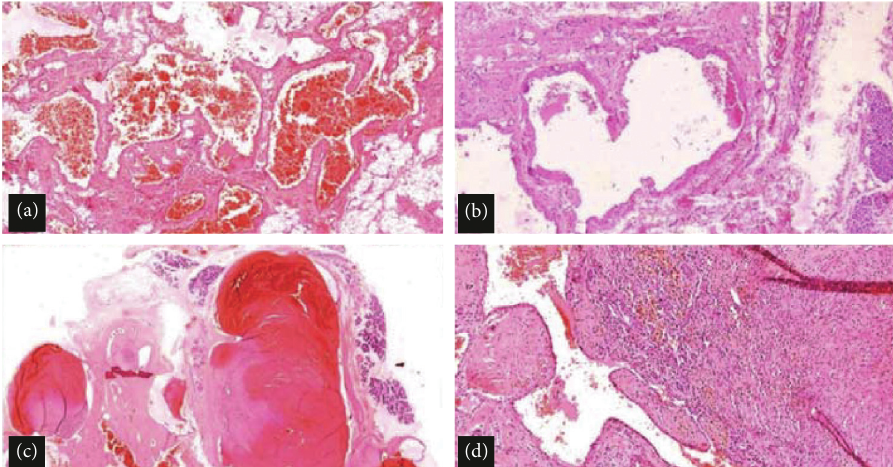
Figure 8 (a): Photomicrograph shows large, ectatic, thin-walled anastomosing vascular channels ( H and E x40); (b) section shows a thin layer of smooth muscle within the walls of the vascular spaces with adjacent salivary acini ( H and E x40); (c) salivary gland acini are seen in between the vascular spaces, with some of them showing fresh thrombi ( H and E x40); and (d) organising thrombus with revascularization in a dilated vascular channel ( H and E